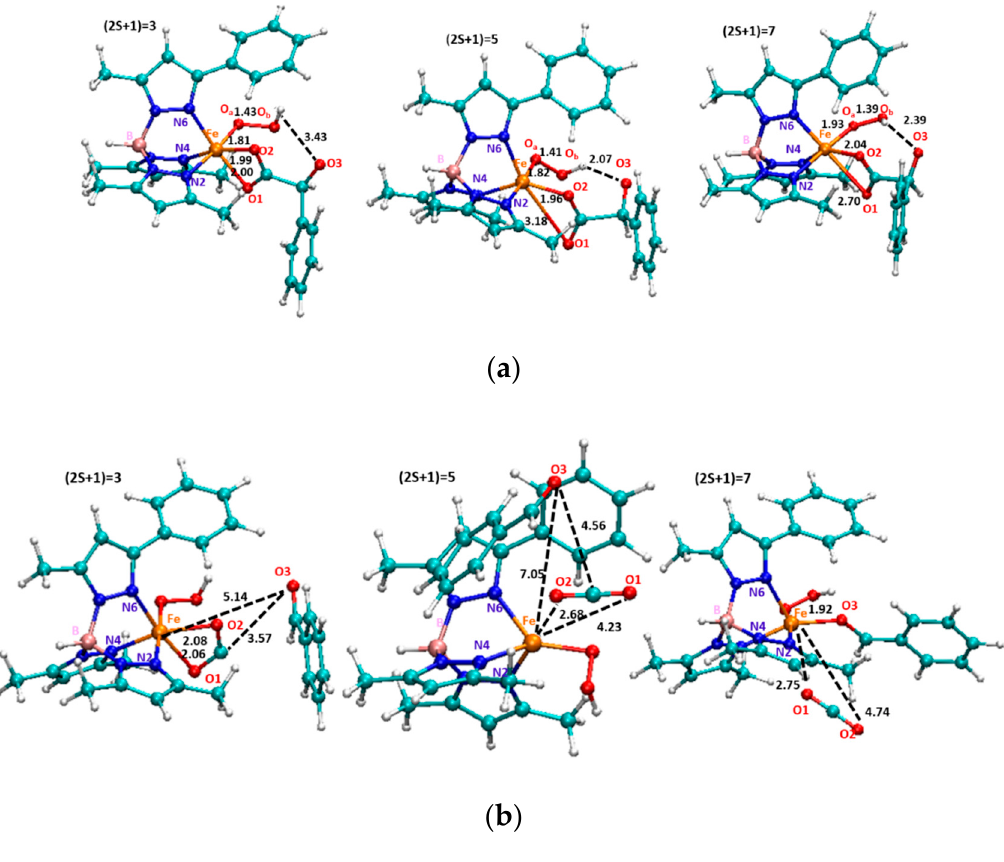
Figure 6. M06L optimized structures and main geometrical parameters of hyproperoxo ( a ) and prod species ( b ) in all the three electronic states considered. Selected bonds are in Å.